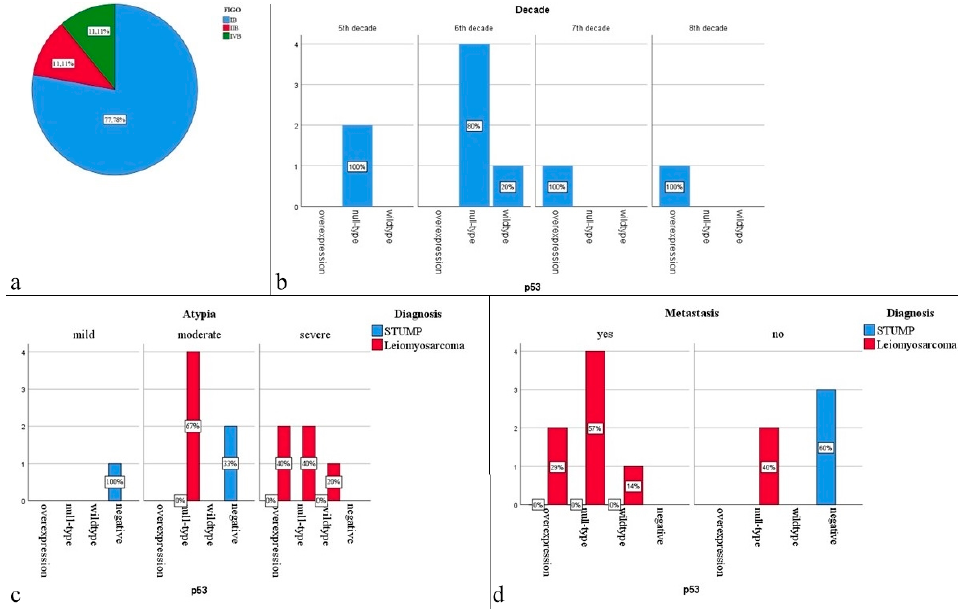
Figure 3. ( a ) FIGO staging distribution; ( b ) the variation of p53 expression according to the decade; ( c ) the variation of p53 expression depending on the cytological atypia and diagnosis; ( d ) the variation of p53 expression according to metastasis and diagnosis.